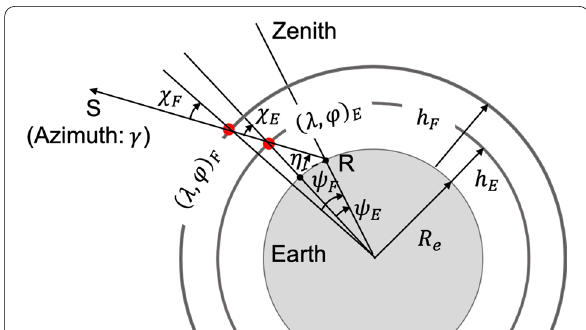
Fig. 2 Typical geometric relation of a GNSS satellite (S) and a receiver (R) in double-thin-shell approximation. η and γ are the elevation and azimuth of the satellite, respectively, χ is the local satellite zenith angle, ψ is the geocentric angle, R e represents the mean radius of the Earth, h E and h F represent the heights of E and F layers, respectively. Red points of intersection ( (cid:31) , ϕ ) are referred to as the ionosphere pierce points